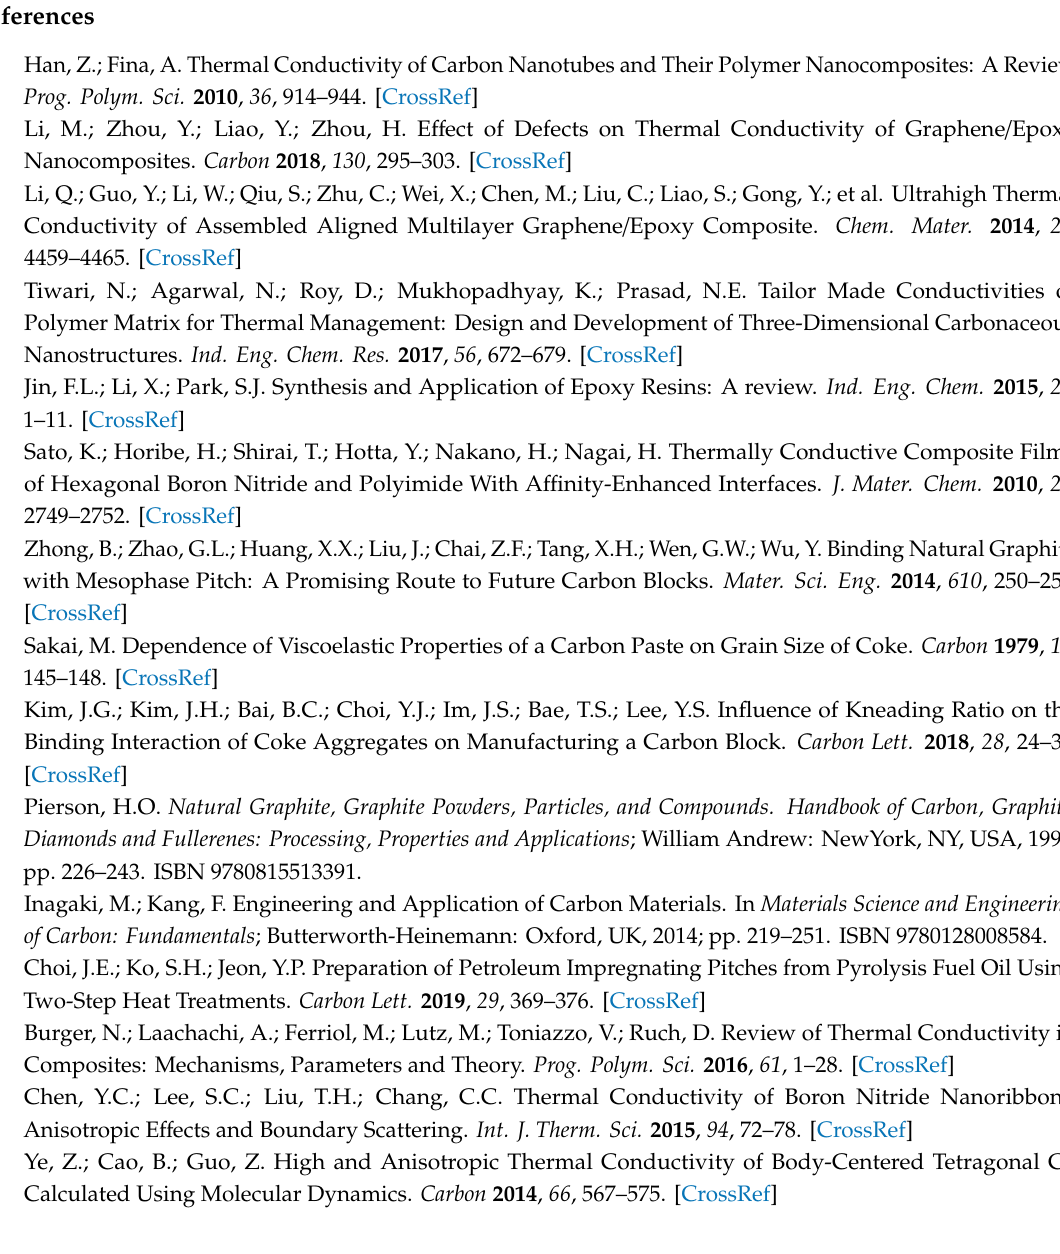
Figure S1: XRD and Raman Spectroscopy analysis of graphite block: (a) XRD data, (b) Raman Spectroscopy data.; Figure S2: Particle size distribution of pulverized needle coke; Figure S3: SEM image of pulverized needle coke and polyaromatic hydrocarbons (PAHs, binder pitch) coated needle coke: (a) pulverized needle coke, (b) coated needle coke; Table S1: Physical properties of polyaromatic hydrocarbons (PAHs, binder